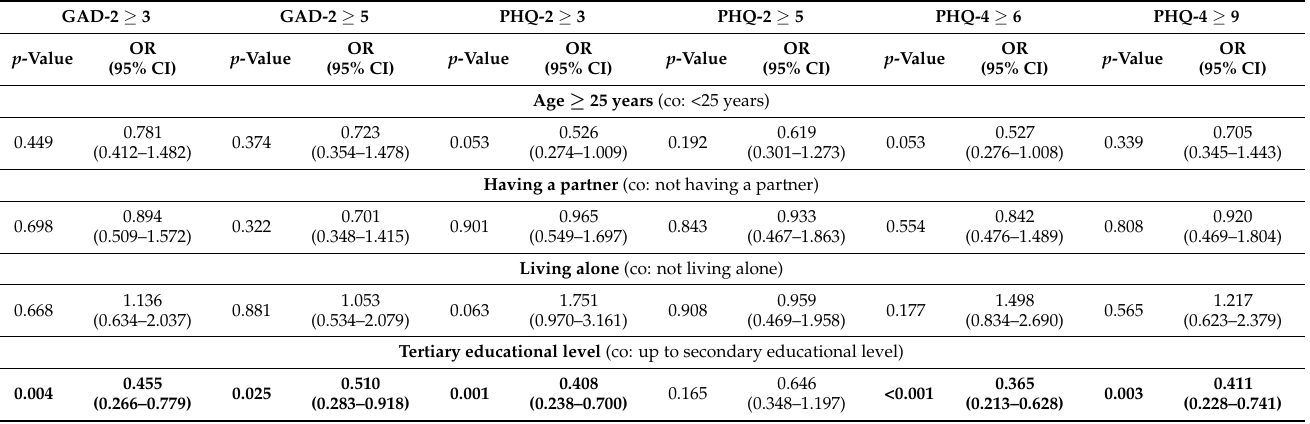
Table 2. Influence of demographic factors on self-reported mental health outcomes (univariate logistic regression analysis).